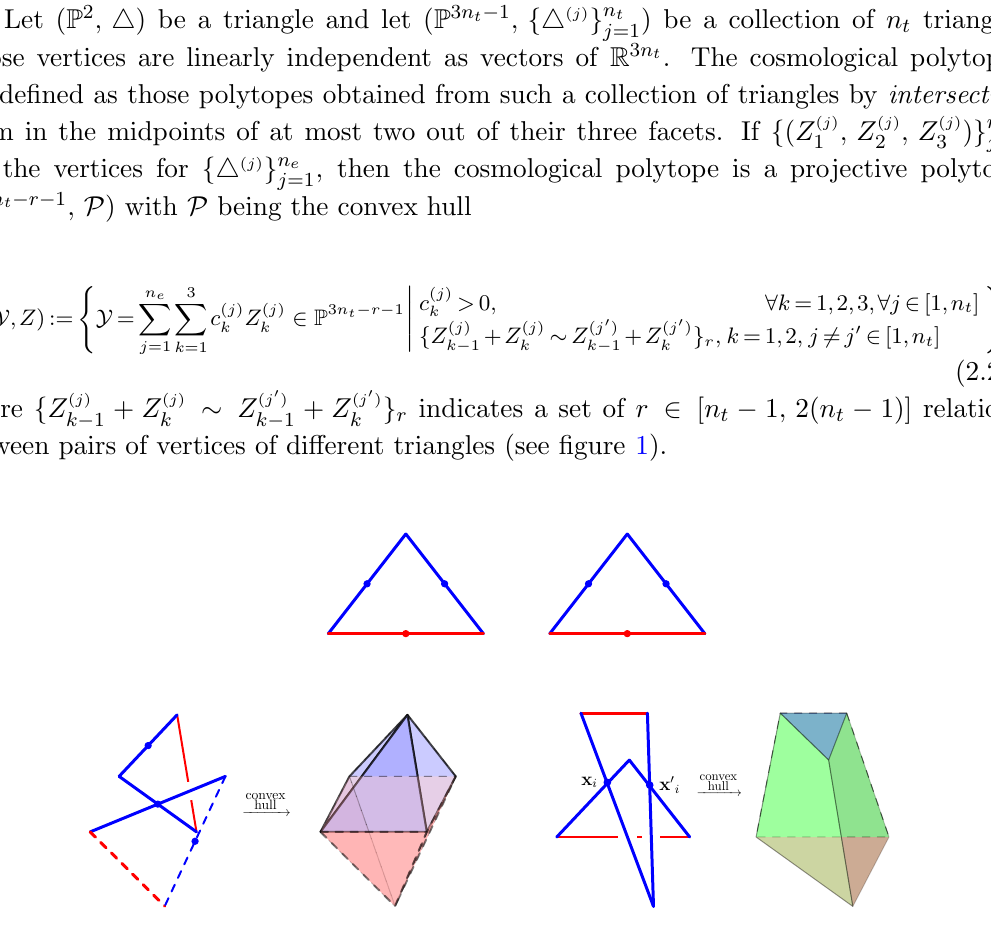
). The (red) blue facets in the j =1